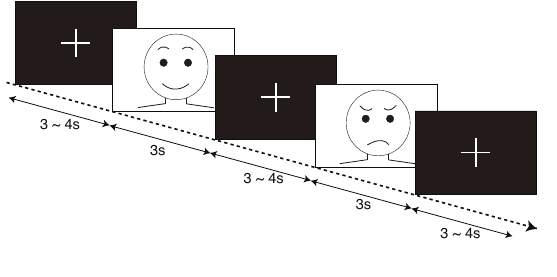
Figure 1. Diagram of stimuli